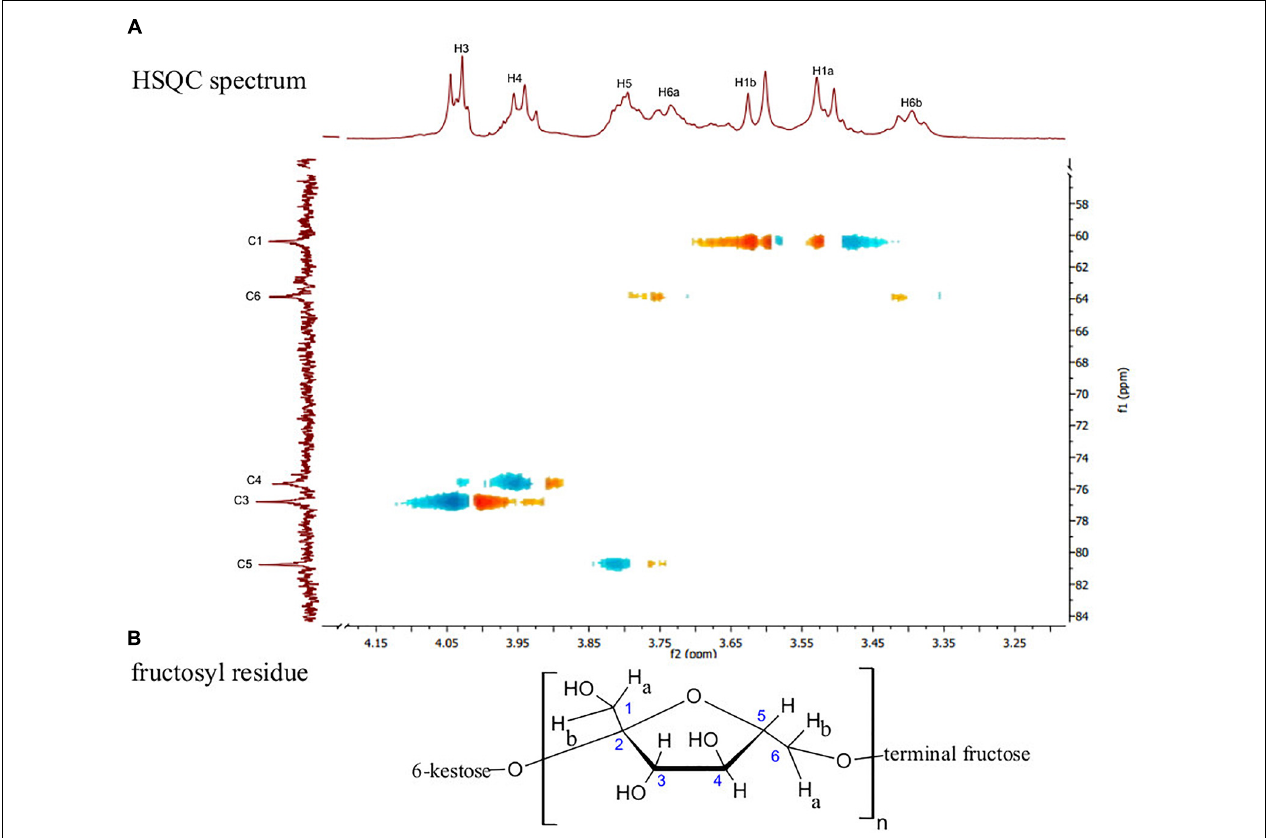
FIGURE 2 | (A) HSQC spectrum in D 2 O showing the direct connectivity between the 13 C and 1 H ( J H / C ) of the fructosyl residue of levan-type fructan polysaccharides from G. marginata stored in the underground system, and (B) Fructosyl residue.